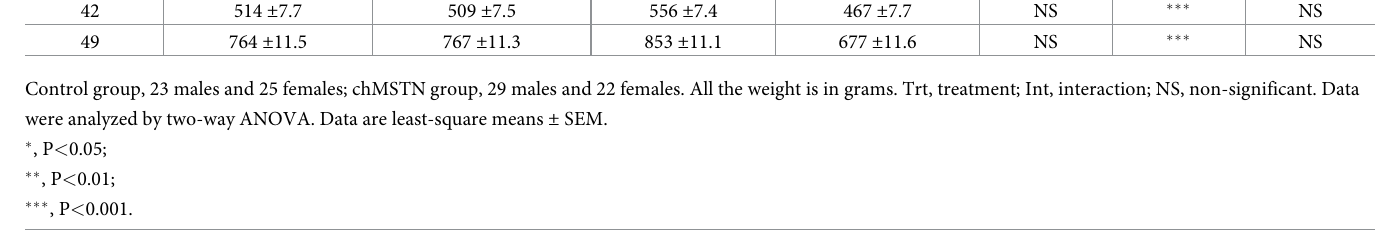
between the chMSTN and Control groups. The bone-in thigh muscle weight of the Myo2 group was also significantly smaller (10.7%) than that of the Control group. In contrast to Experiment 1, the breast muscle weight, and its percentage to the body weight of the chMSTN group was significantly lower than those of the Con group. The growth period differed between Experiment 1 (7 weeks) and 2 (11 weeks). Close examination of the growth data of